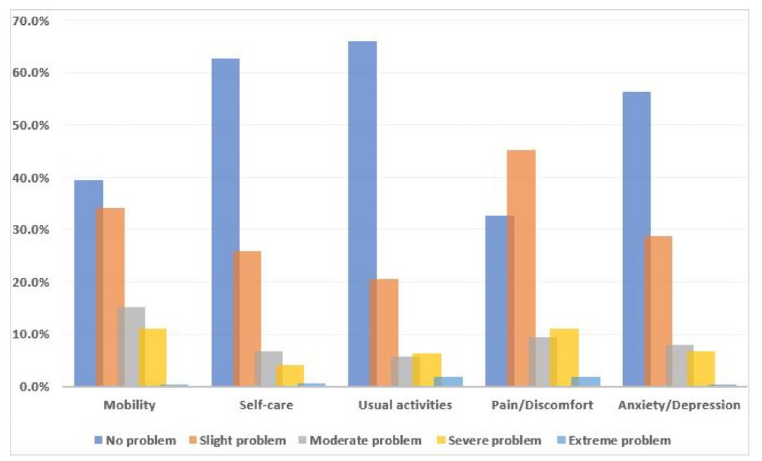
Fig 1. Percentage distribution of self-reported health problems among patients with T2DM.